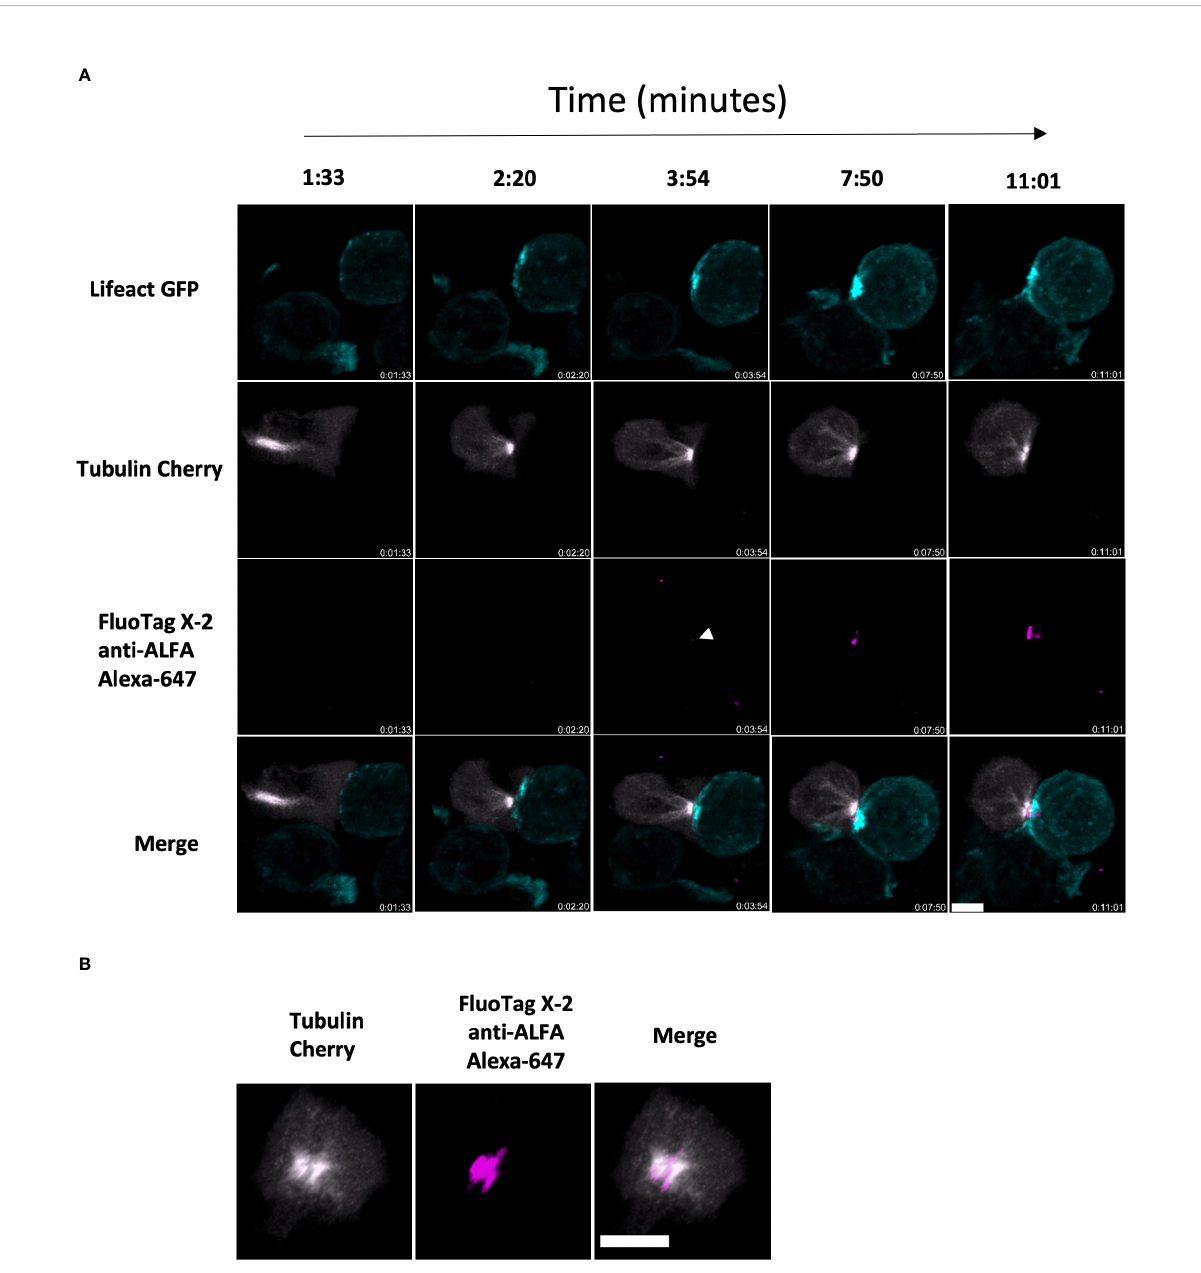
FIGURE 5 ALFA-PRF-TMH release can be detected within a bona fi de synapse between CD8 T cell and antigen presenting target cell (A) Side on montage showing release of ALFA-PRF-TMH (magenta) in the area between the polarised MTOC of mCherry-tubulin expressing Prf1 -/- .OTI CD8 T cells (grey) and the Lifeact GFP expressing EL4 target cell (cyan). White arrow head indicates point of fi rst ALFA-PRF-TMH detection. Synapse interaction shown is a representative example from three fi elds of view (containing >5 synapse interactions each) of two biological replicates (mice). (B) En face view of the synapse from timepoint 11:01 in a.) showing the location of the Perforin within the synapse area. For clarity, brightness and contrast of images has been altered. Scale bars =